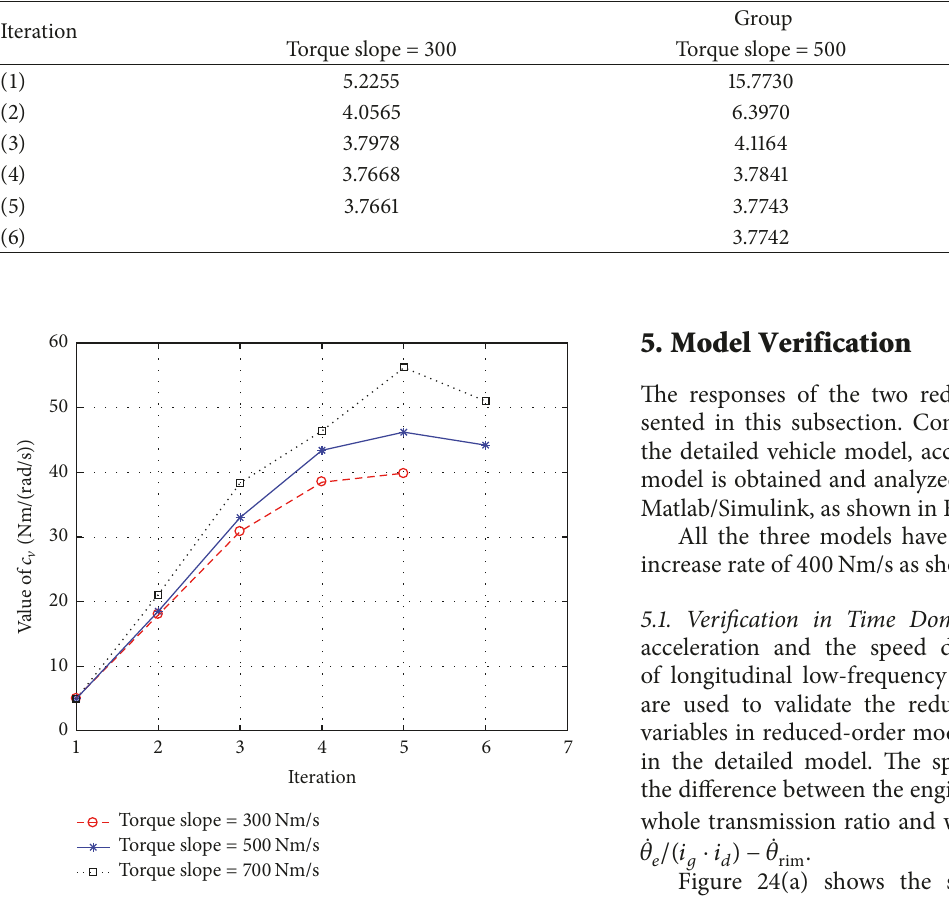
Figure 21: Parameter trajectories during the estimation.